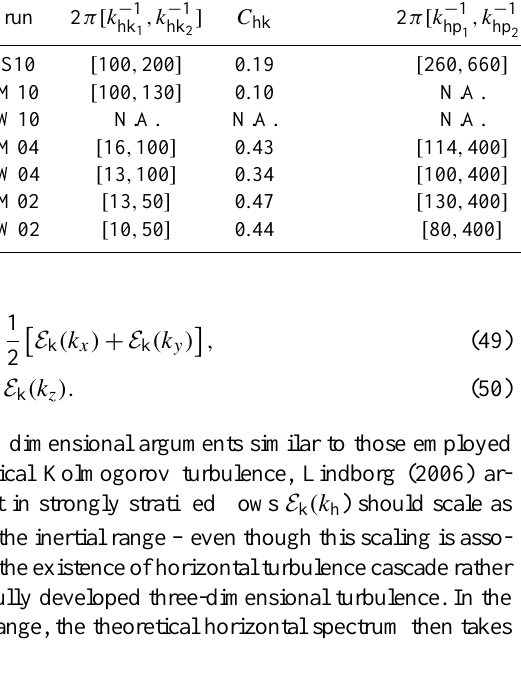
] ; and combined kinetic and potential energy spectra [ k hp 1 ,k hp 2